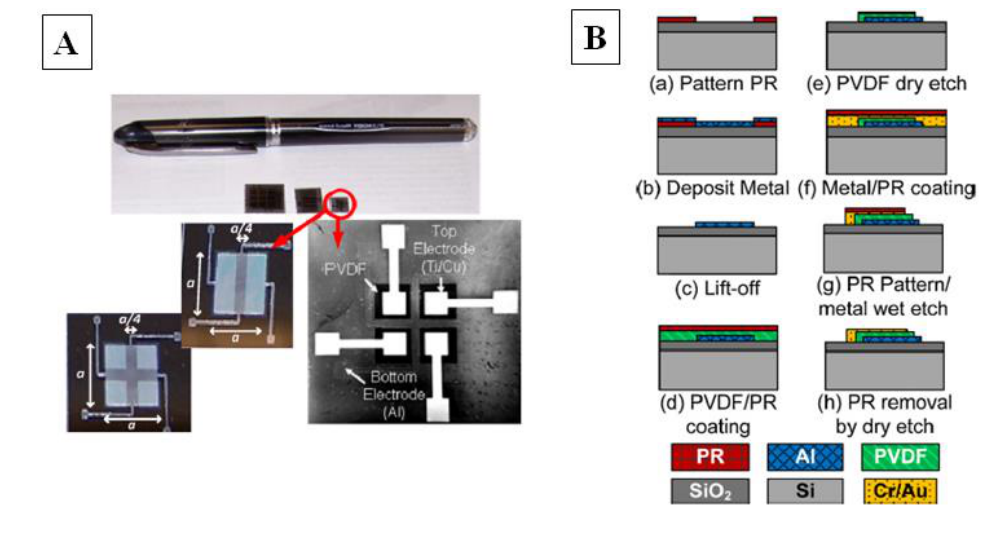
Figure 3. ( A ) Pictures and ( B ) fabrication process of film PVDF–TrFE based pressure sensor for catheter application